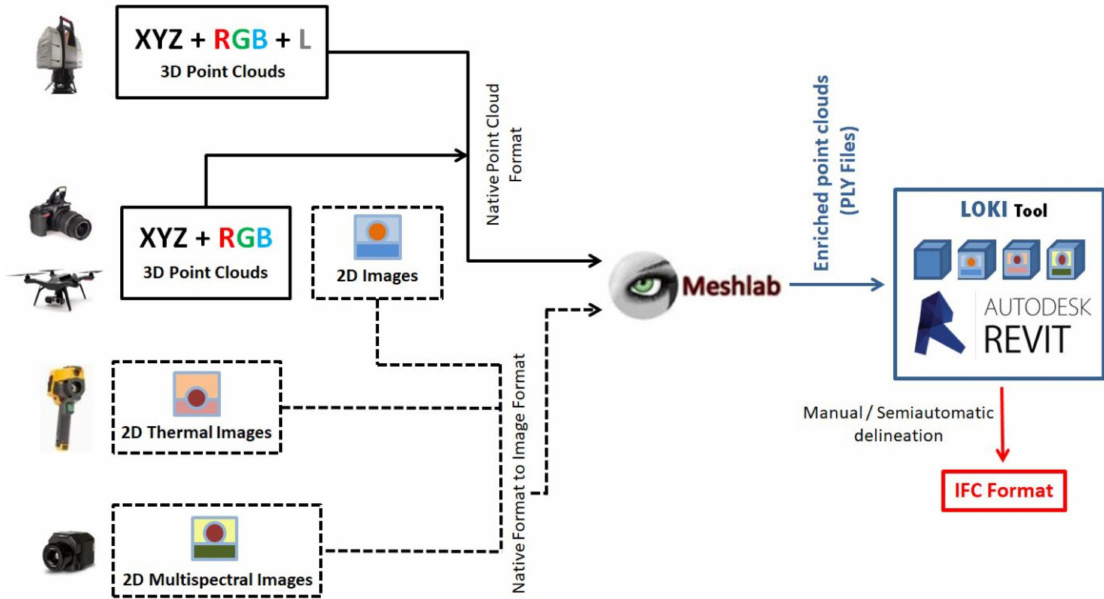
Figure 2. Tailored process for combining 3D data and 2D imaging into REVIT through the LOKI tool for heritage